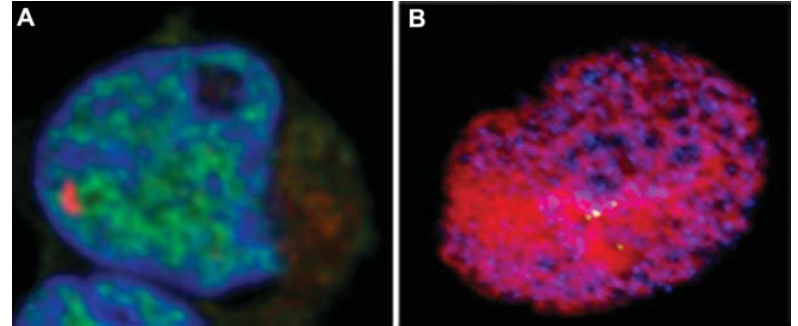
Figure 5 EBV genomes and pEPI are associated with active histone modifications. (A) EBV is shown to associate with histone 3 lysine 9 acetylation (H3K9ac). The colocalization of EBV genomes with H3K9ac was determined with a combination of immunofluorescence techniques using Raji cells. H3K9ac is shown in green, the EBV genome of Raji cells in red, and the DNA counterstain in blue w with permission from A. Schepers (86) x . (B) pEPI molecules (green/white) colocalize with H3K9ac and H3k14ac (blue) in CHO cells. CHO genome is stained red w with permission from J. Postberg (88) x